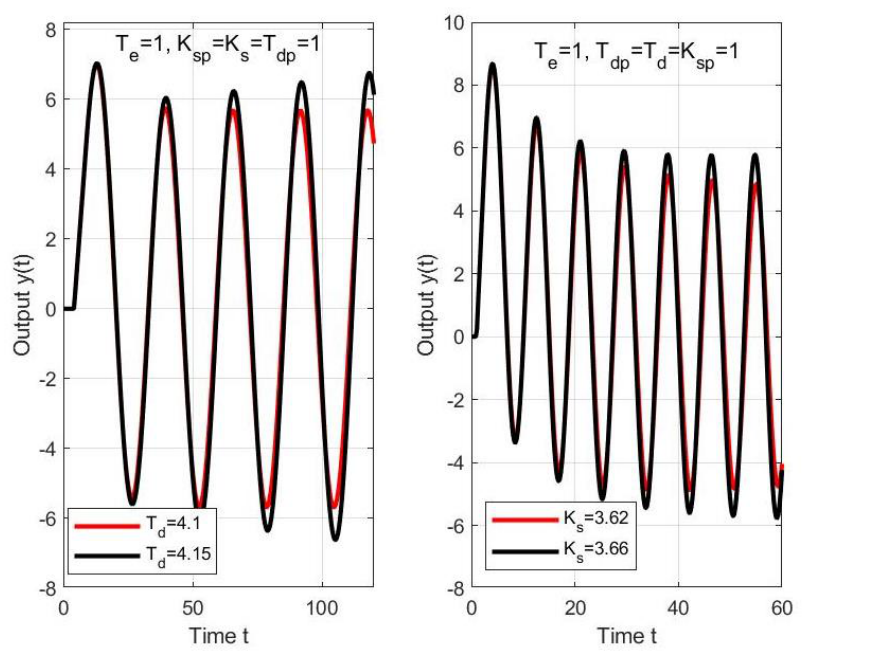
Figure 4. Verifying the dead-time and gain margins of the PID 0 the T f = T e /2 tuning